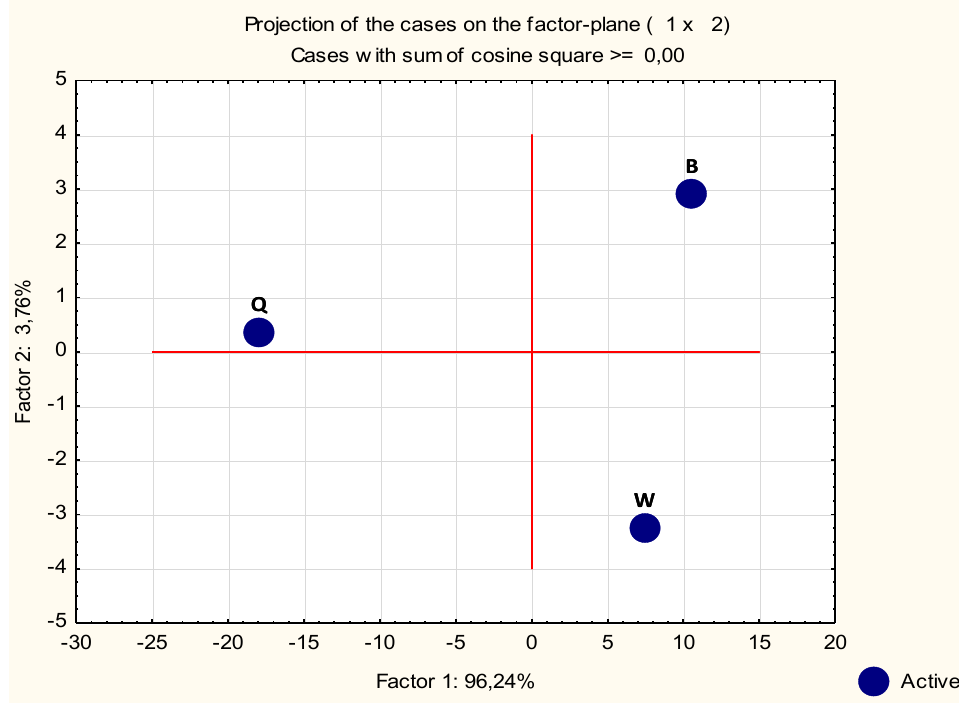
Figure 3. Principal Components Analysis (PCA) projection of three growth media normalized microarray probes values. The elements of this data set presented a scattered distribution, suggesting that the microarray results indeed diverge among them. Factor 1 axis shows the majority of the deviation, 96.24%, and Factor 2 axis contributes only with 3.76%. According to this PCA analysis the overall observation of B and W seem to be more closely related between them than with Q, however B and W also deviate in a smaller